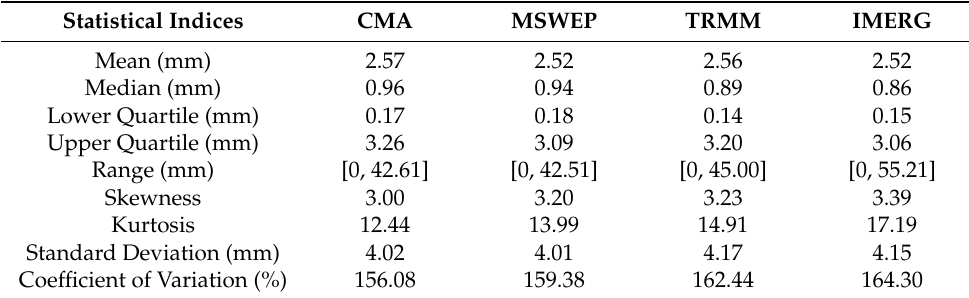
Table 2. Summary of daily statistical results of the precipitation products in the study area.